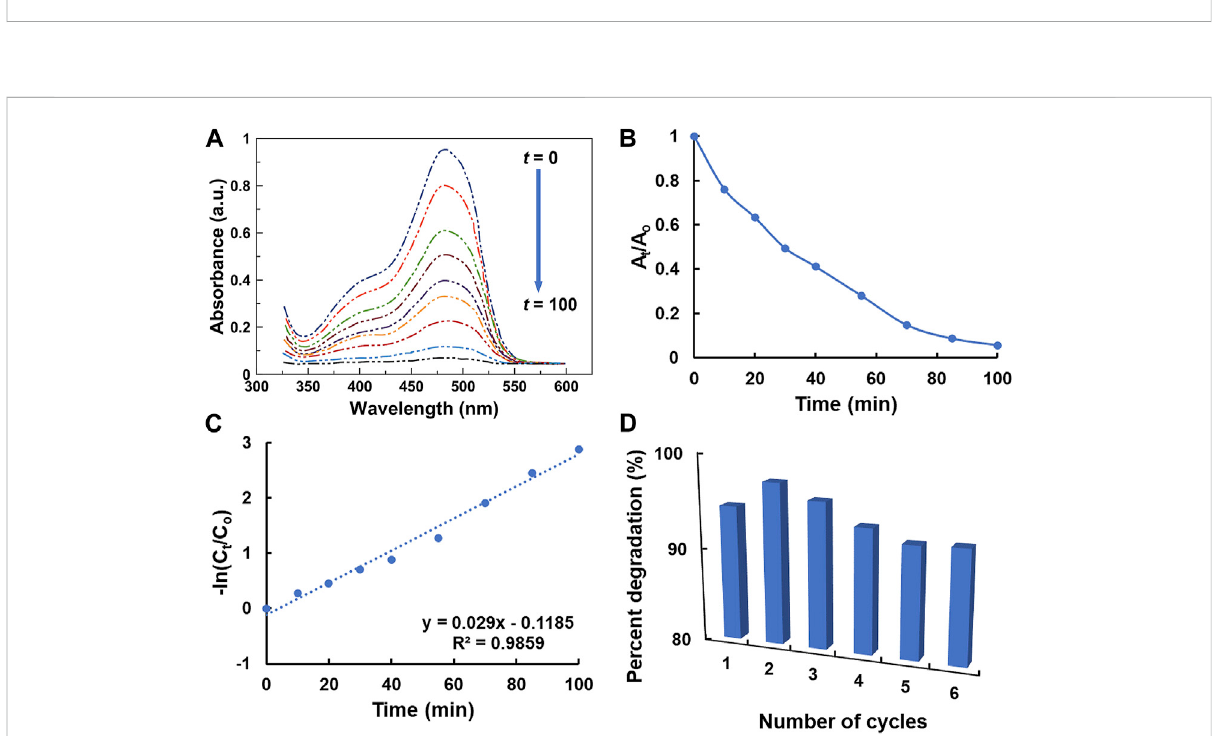
FIGURE 4 (A) The time-dependent photocatalytic performance of ZnO/Zn(OH) 2 coatings: UV-vis spectra of the sunset yellow solution at different intervals ( t =0 – 100 min)ofUV light( λ = 365 nm)irradiation. (B) A relationship oftheinitial ( A o )and time-dependent ( A t )absorbance ofsunset yellow with UV irradiation time ( t ). (C) A kinetics analysis: pseudo fi rst-order kinetics ( -ln ( C t /C o ) vs. t ) of the photocatalytic degradation of sunset yellow. (D) Recyclability of the photocatalytic ZnO/Zn(OH) 2